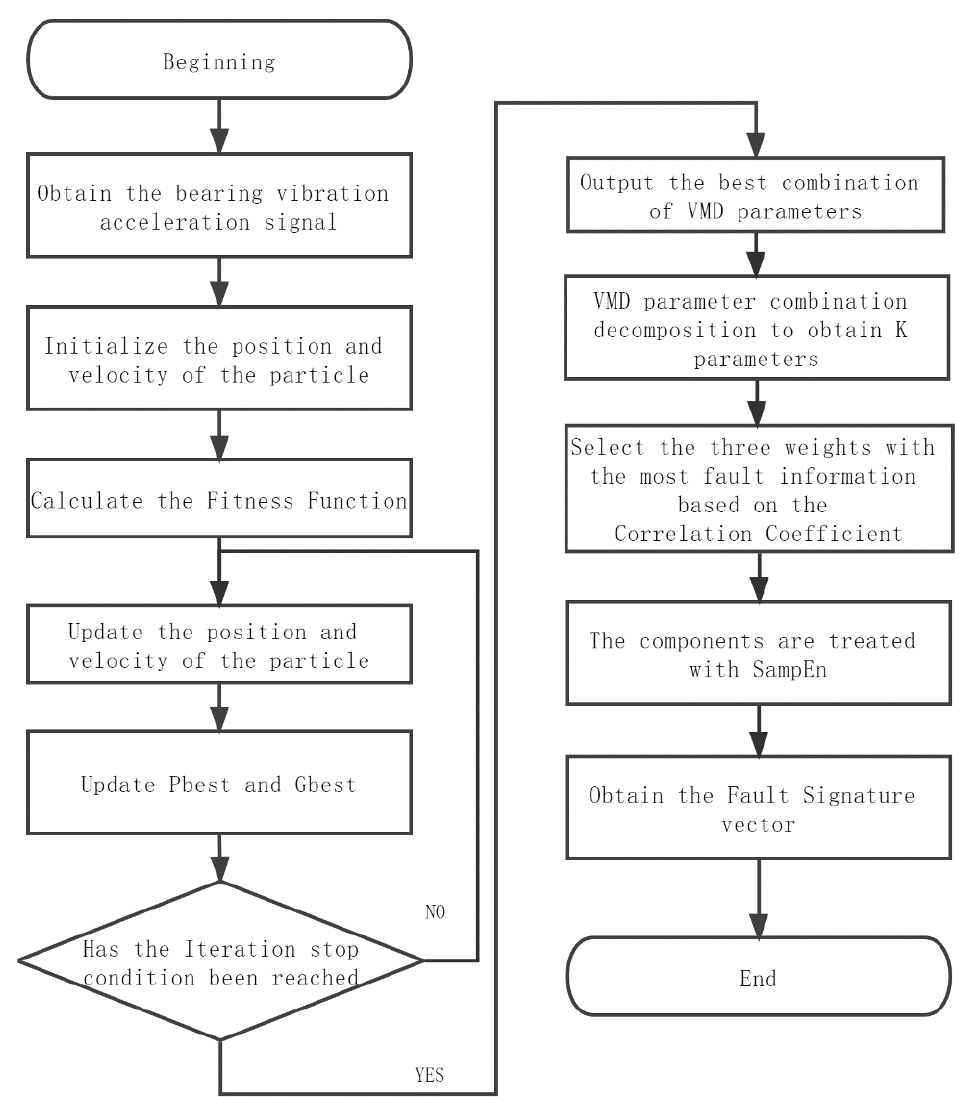
Figure 1. The Fault Feature Extraction Algorithm Flow Chart based on